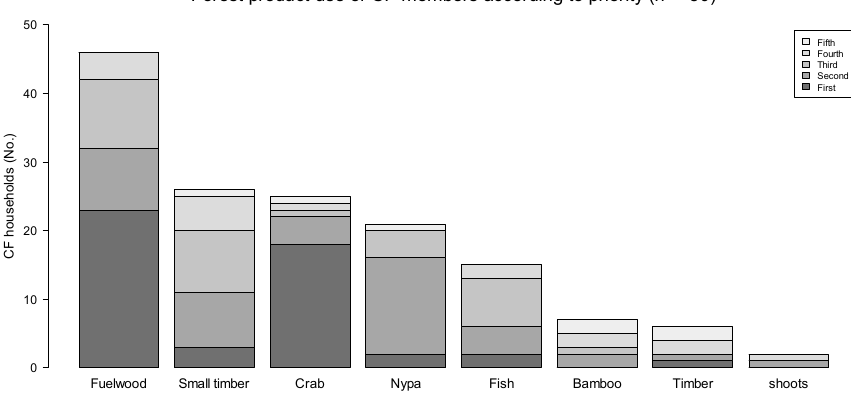
Figure 4. Use and importance of mangrove products by members of the CFUG.